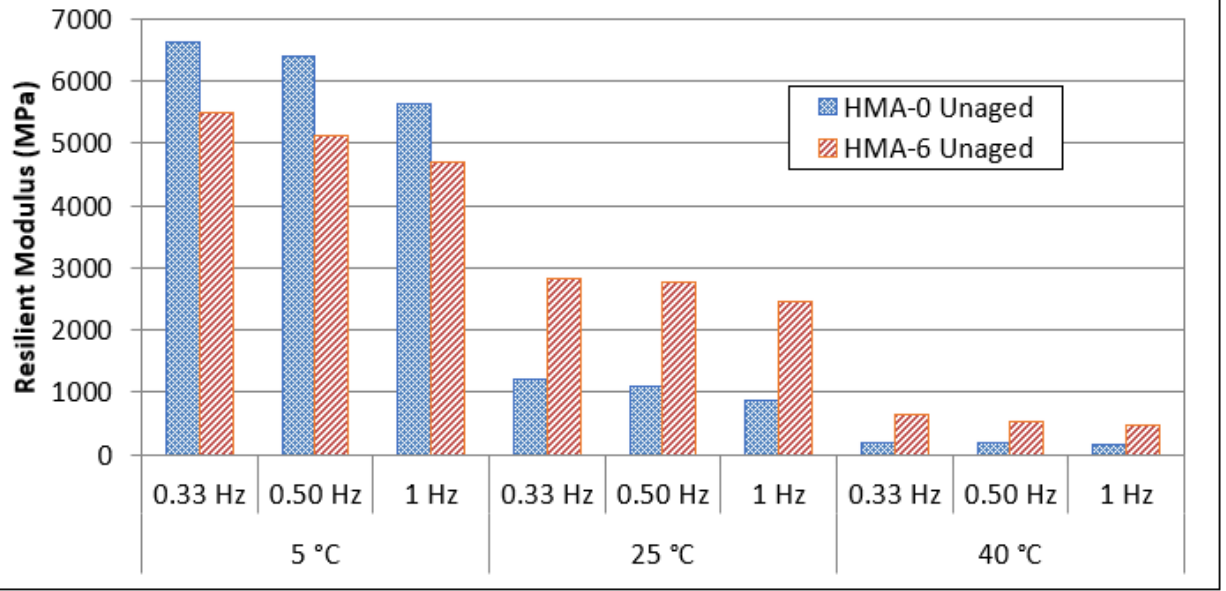
Figure 4. Resilient modulus of unaged HMA mixes.